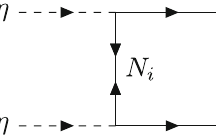
Fig. 5 Feynman diagrams of the annihilation processes responsible for creating lepton asymmetry in fermion DM